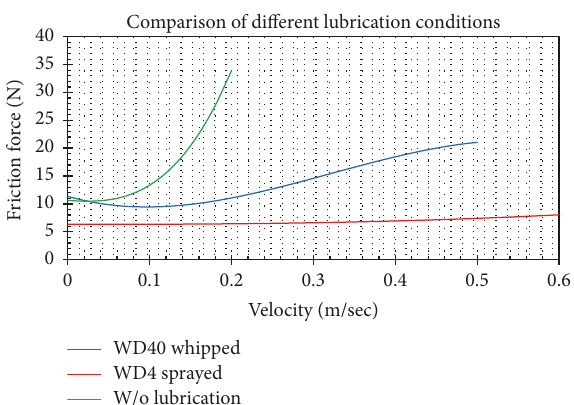
Figure 10: The comparison of function of overall best fit and friction force with various lubricated conditions.